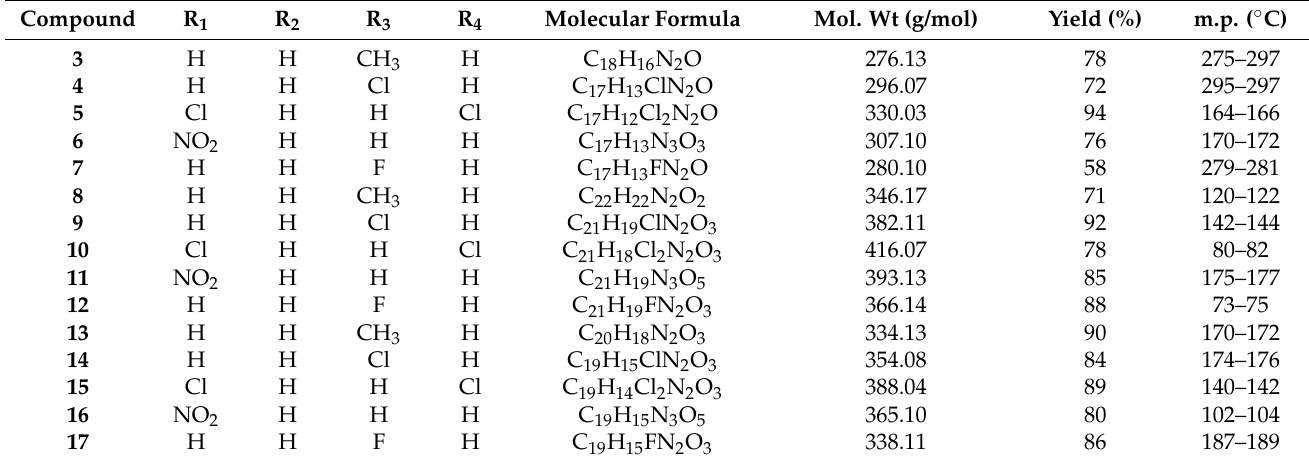
Table 1. Physical data of the synthesized compounds ( 3 – 17 ).